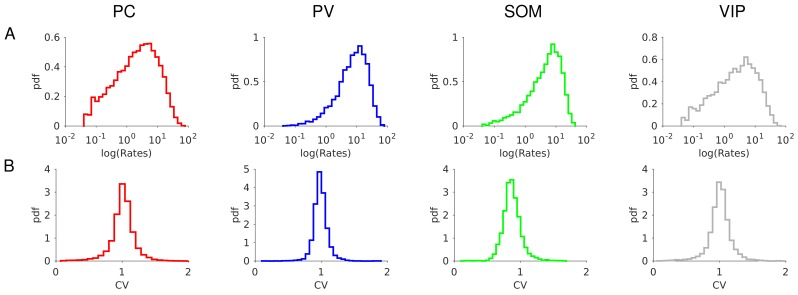
Model 1 with JEE<JEE∗.Firing statistics at baseline. (A) Distribution of the firing rates (mean: rE = 4.8 Hz, rI = 11.2 Hz, rS = 7.1 hz, rV = 5.3 Hz). (B) Distribution of CV. Individual rates are average over 100s with a threshold at 0.05Hz. CVs are computed over 30s. Color code as in Figure 7. Parameters as in Figure 7.